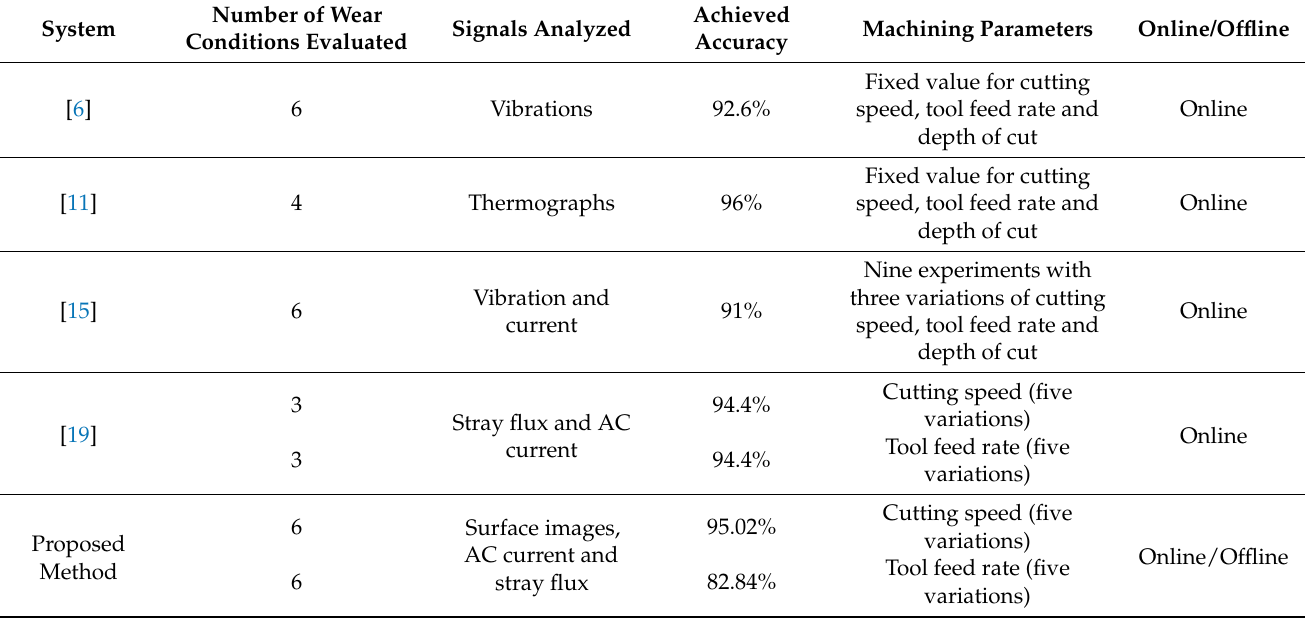
Table 8. Comparison of the proposed methodology to systems reported in the